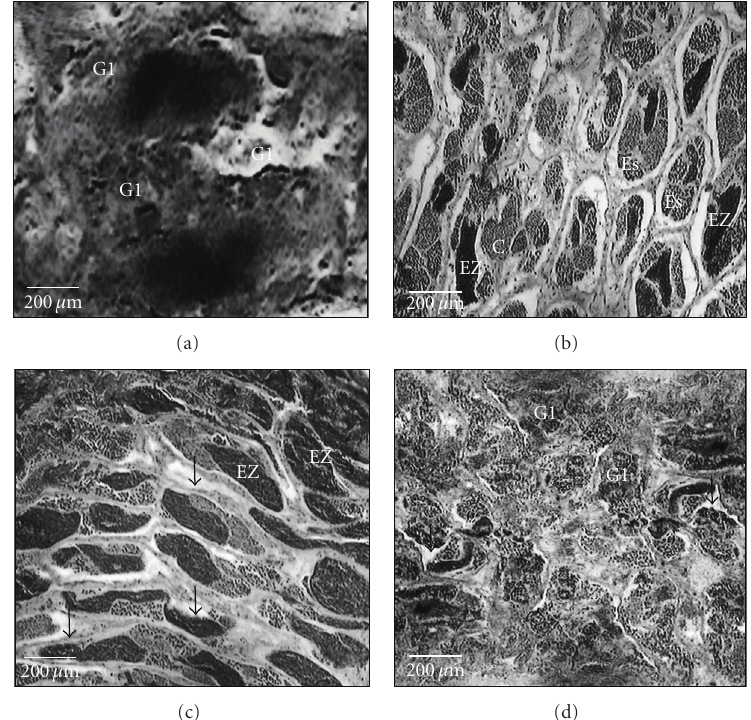
Figure 5: Histological aspects of testicles of C. menezesi showing di ff erent stages of development: (a) immature testes with primary spermatogonia (G1); (b) maturing testes with spermatocytes (C); spermatids (Es) and spermatozoa (EZ); (c) mature testes with spermatozoa (Ez) and seminiferous tubules-arrows; (d) partially spent stage with primary spermatogonia and seminiferous